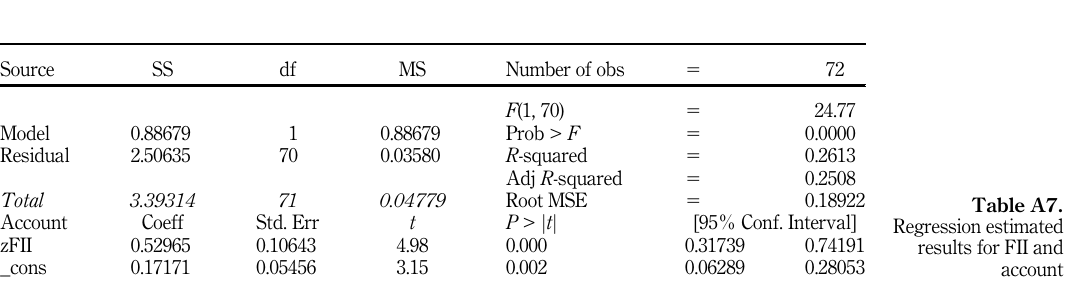
Table A6. Scoring coefficients